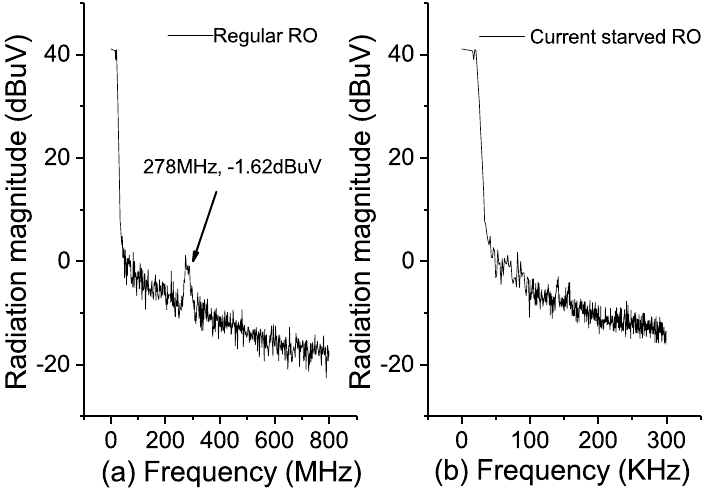
Figure 11. ( a ) The measured EM radiation for the regular RO; ( b ) the measured EM radiation for the proposed